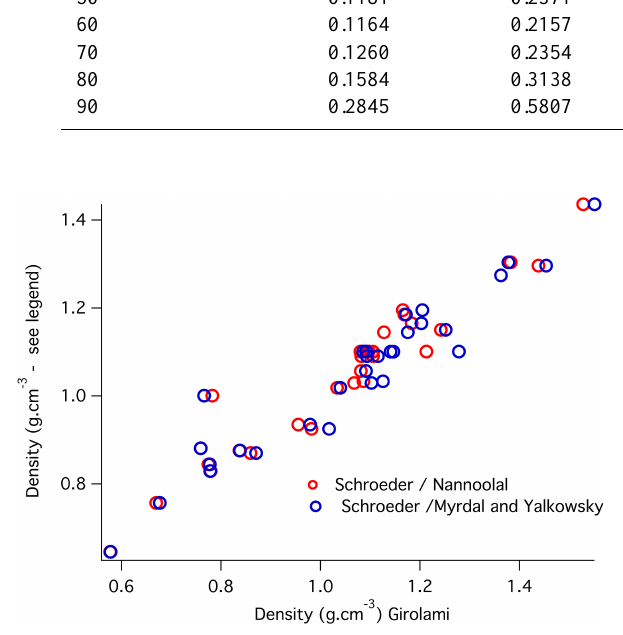
Figure 3. Predictions of pure component density (gcm − 3 ) at 298.15K using the compounds described by Barley et al. (2011), the compound list provided in Appendix A. Methods used include those of Schroeder (Poling et al., 2001) combined with critical prop- erty estimation by both Joback and Reid (1987) and Nannoolal et al. (2008), compared to the method by Girolami (1994).